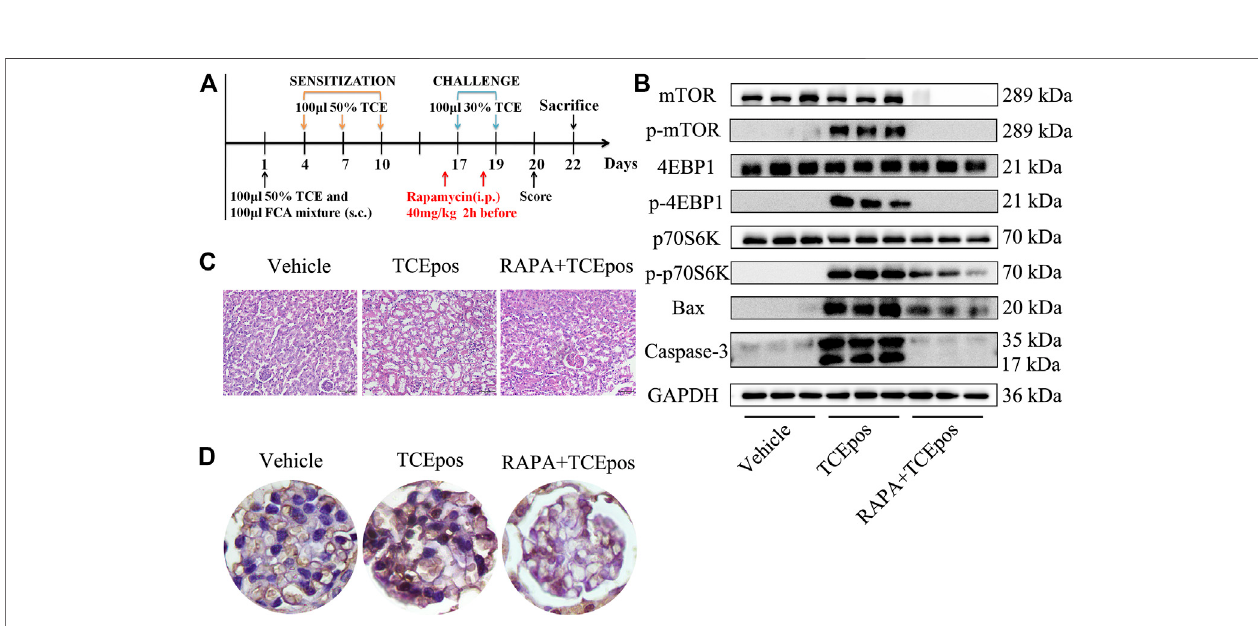
FIGURE 7 | mTORC1 pathway inhibition alleviated the glomerular damage in TCE sensitization. (A) mTORC1 inhibitor (rapamycin, RAPA) was applied to mice by intraperitoneal injection at 40 mg/kg 2 h before each challenge. (B) Phosphorylation process of mTOR signaling molecules were almost blocked and the proapoptotic moleculesBaxandcaspase-3werealsodeclinedinRAPA+TCEposgroupaccordingtowesternblotbands( n (cid:1) 3pergroup). (C) Thepathologicalchangesofglomeruli wereimproveddramaticallyinmicefromRAPA+TCEposgroup. (D) TherepresentativephotographofTUNELstainingshowedlessdeadglomerularcellsinRAPA + TCEpos